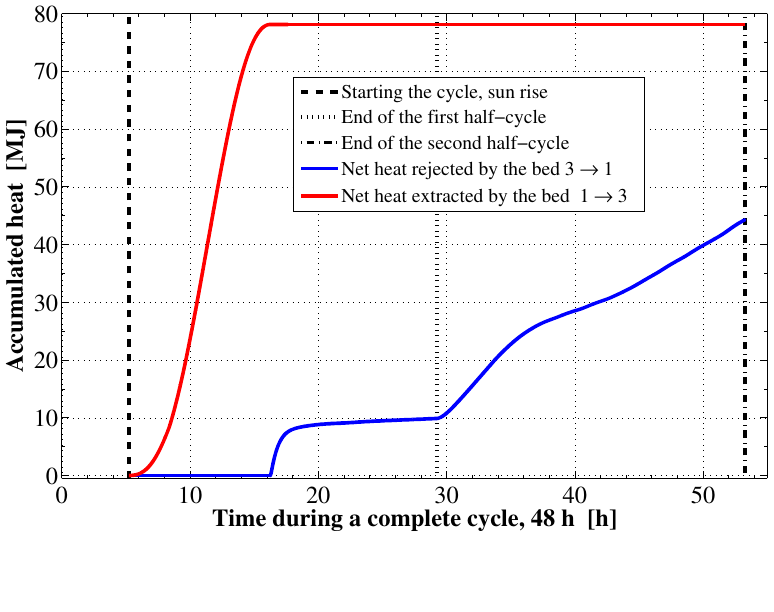
Figure 8. Time integrated heat added to and rejected from the